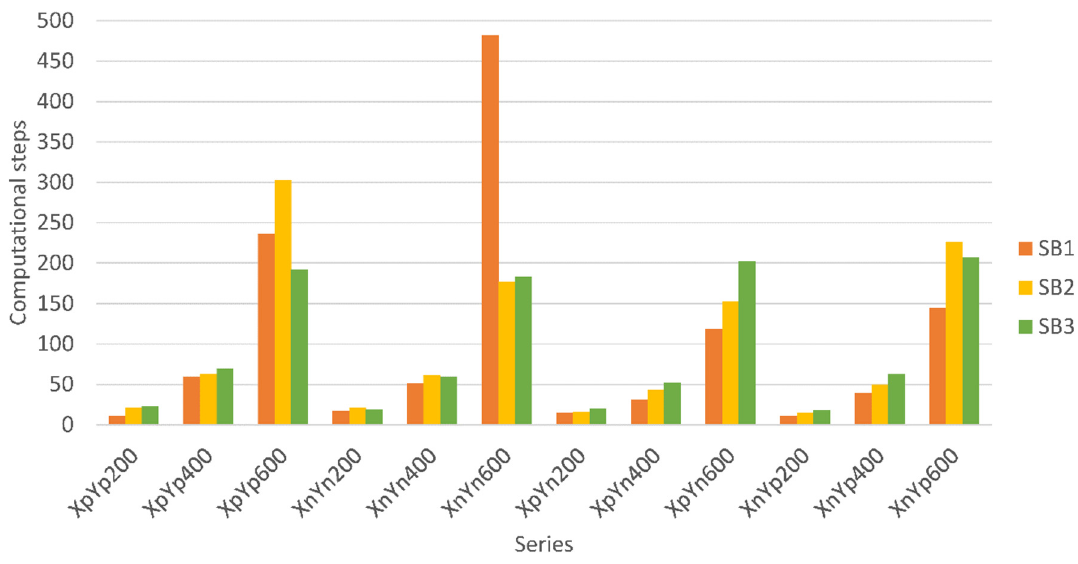
Figure 7. Computational steps in series under bi ‐ directional mode.